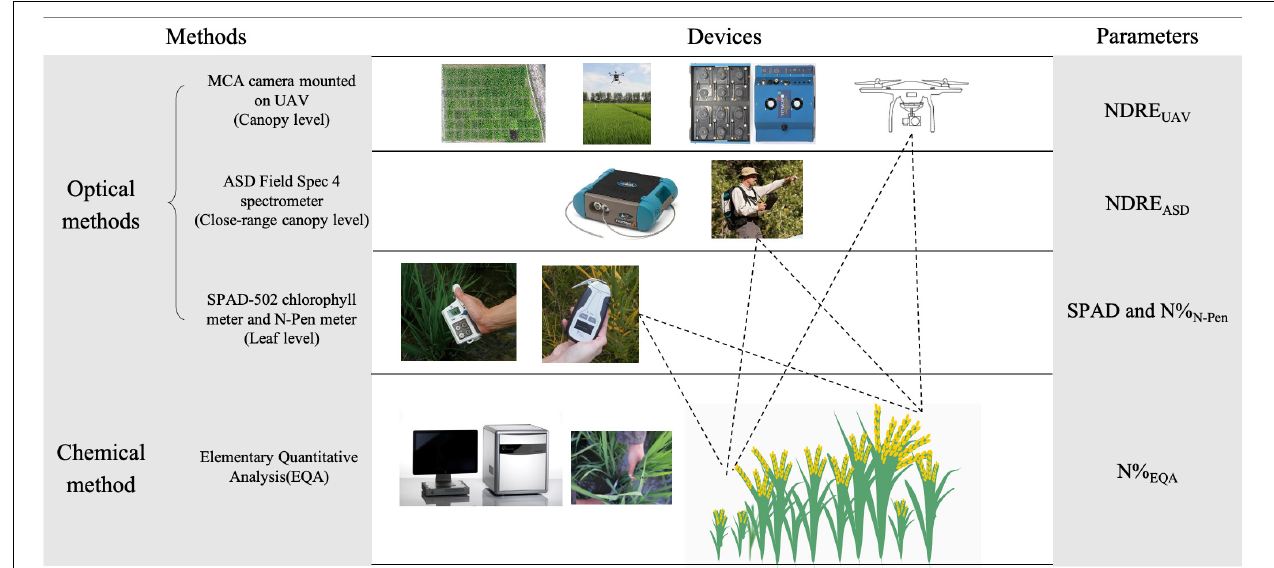
FIGURE 1 | Schematic overview of measured parameters by different methods and devices. NDRE, Normalized Difference Red Edge Index; NDRE UAV , NDRE calculated with the canopy reflectance obtained by UAV; NDRE ASD , NDRE calculated with the close-range canopy reflectance obtained by ASD; SPAD, SPAD value measured by SPAD-502 chlorophyll meter; N% N - Pen , nitrogen content measured by N-pen meter; N% EQA , nitrogen content measured by elementary quantitative analysis